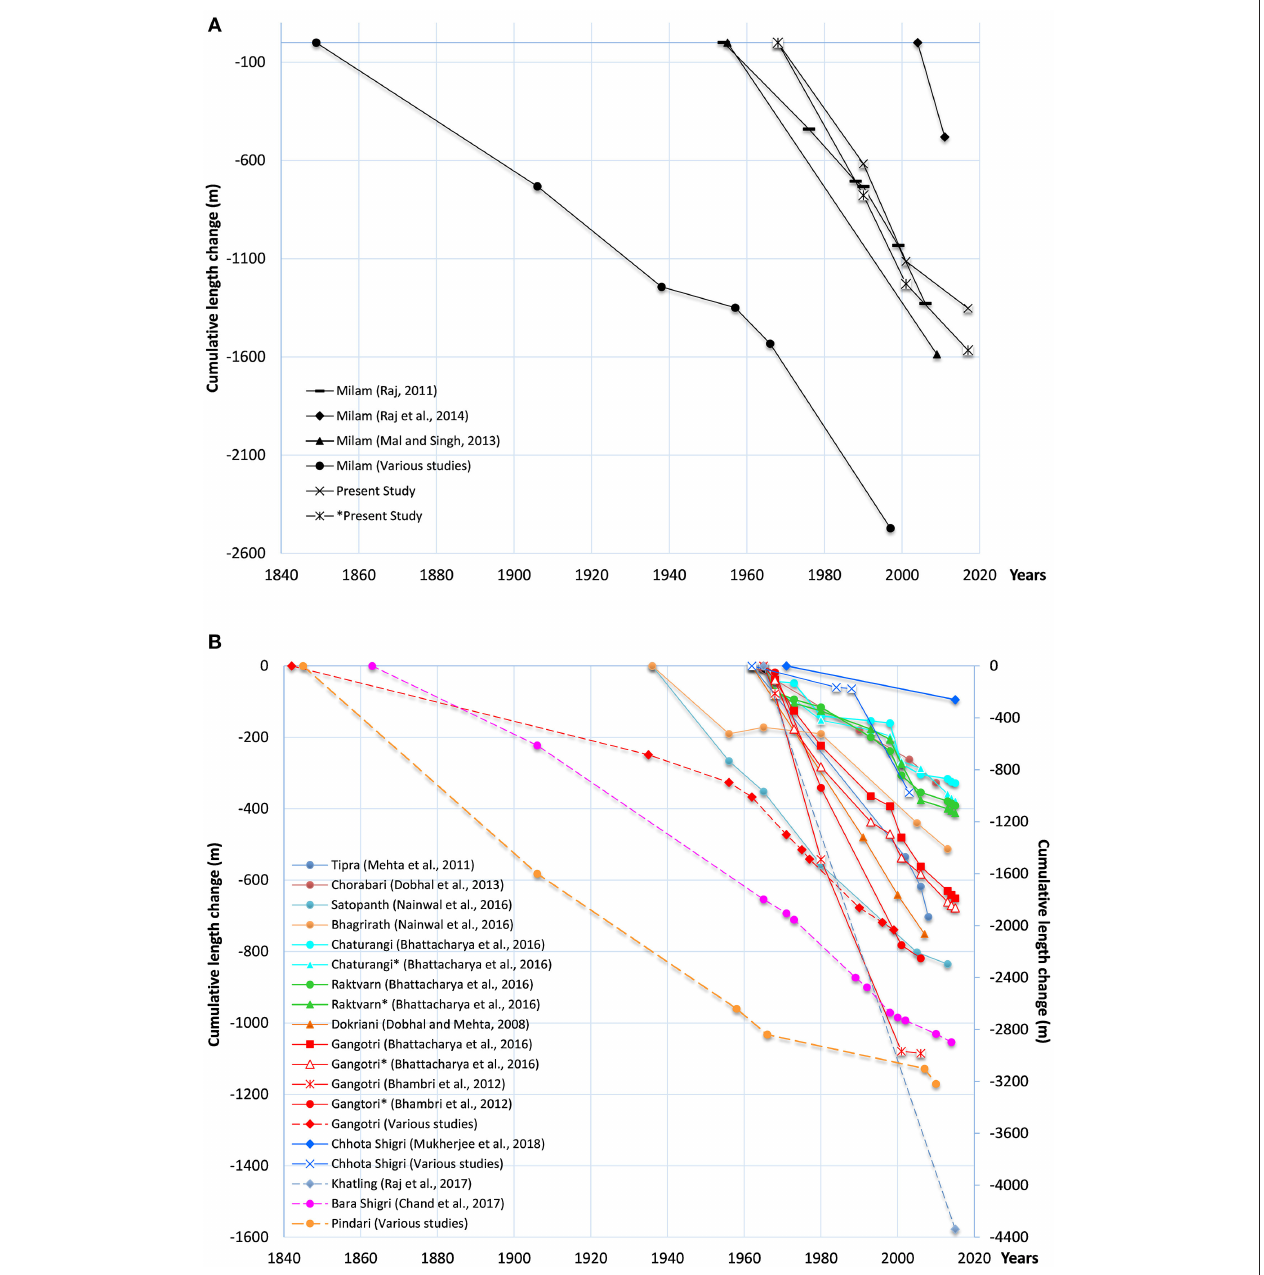
FIGURE 5 | Observed long-term cumulative changes of some of the Himalayan glaciers. (A) Shows long-term changes of the Milam glacier based on present and previous studies. (B) Indicates long-term changes of nearby glaciers. The markers show the year of observations. The axis on the right side is for the dashed lines. *refers to the studies based on frontal recession. Sources: various studies for the Milam glacier (Cotter and Brown, 1907; Mason, 1939; Jangpangi and Vohra, 1959; Jangpangi, 1975; Shukla and Siddiqui, 2001), the Gangotri glacier (Auden, 1937; Naithani et al., 2001; Srivastava, 2004; Thayyen, 2008; Bhambri and Bolch, 2009), the Pindari glacier (Cotter and Brown, 1907; Tewari and Jangpangi, 1962; Tewari, 1972; Bali et al., 2013), Chhota Shigri (Wadia Institute of Himalayan Geology (WIHG), 1987; Kulkarni et al., 2007; Ramanathan, 2011), based on Bhambri and Bolch (2009) and Chand et al.